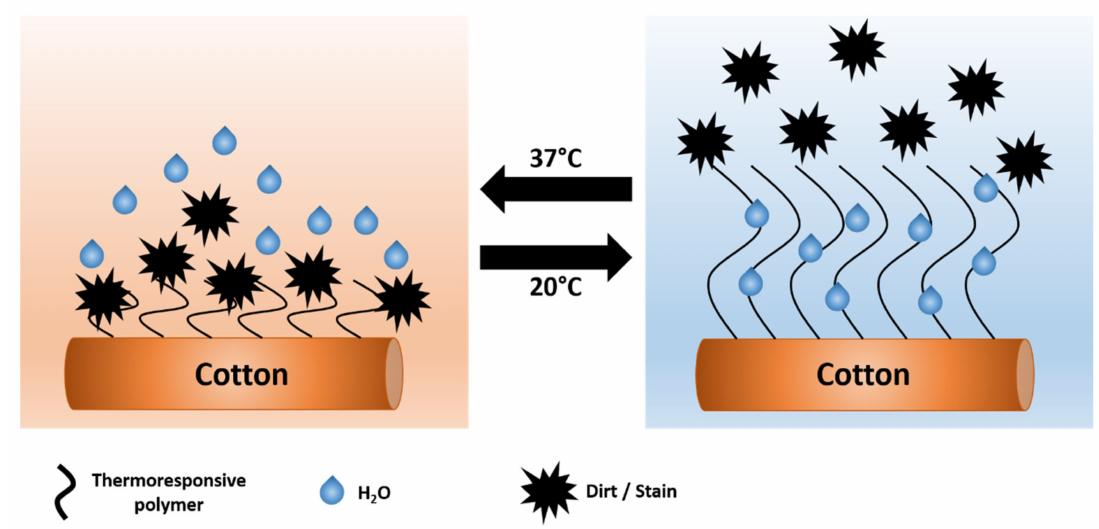
Figure 1. Schematic representation of the self-cleaning of a thermoresponsive polymer-grafted cotton